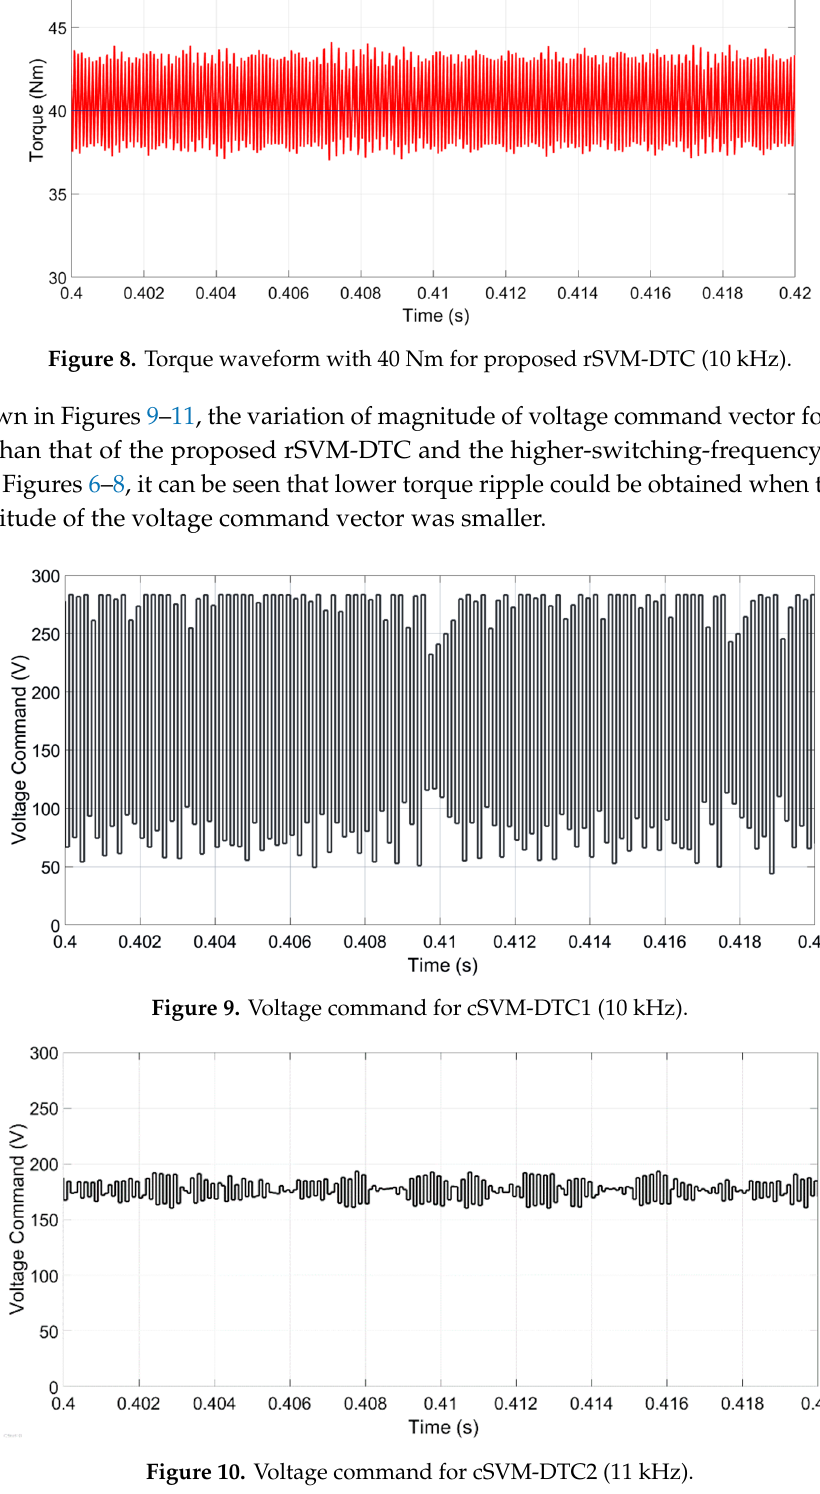
Figure 10. Voltage command for cSVM-DTC2 (11 kHz).